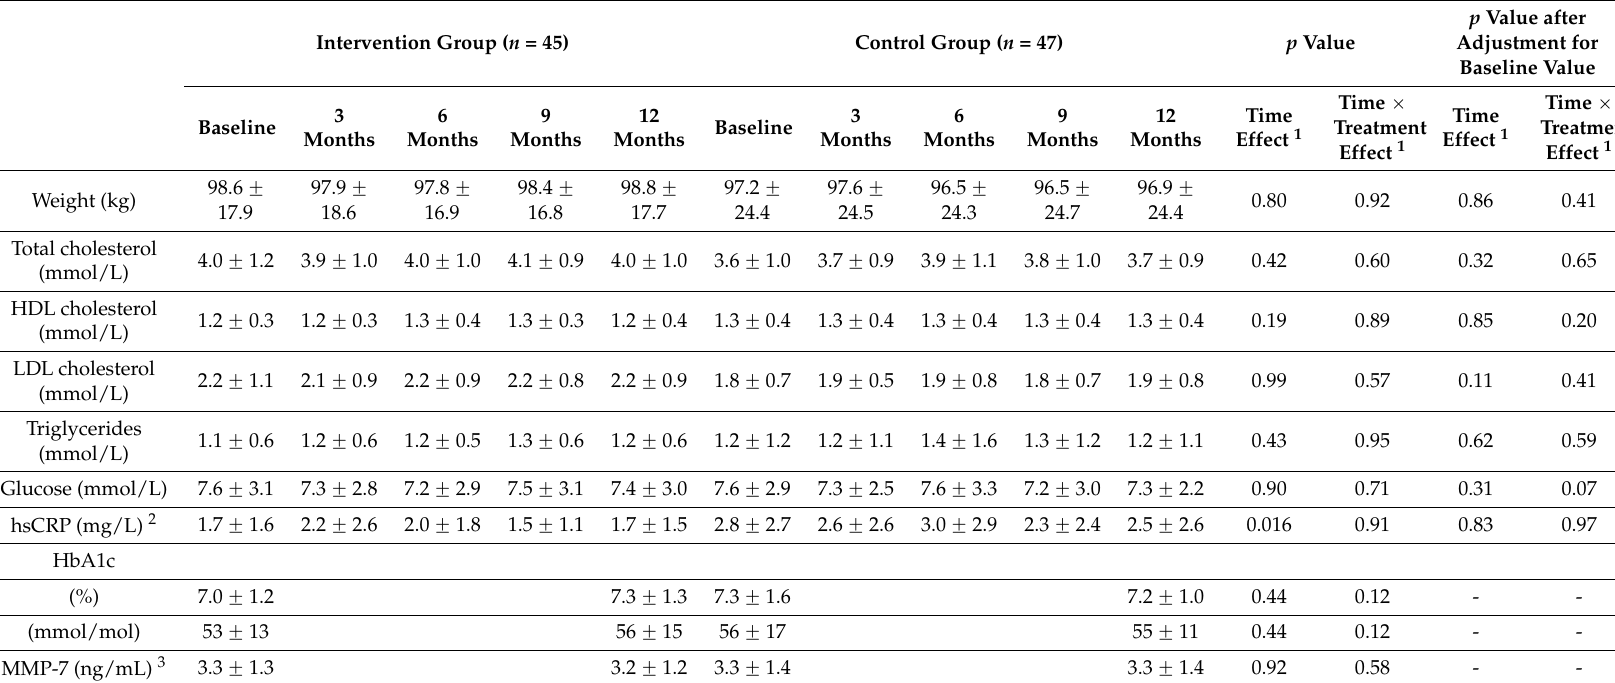
Table 3. Change in weight and biochemistry by treatment group over the 12 months intervention